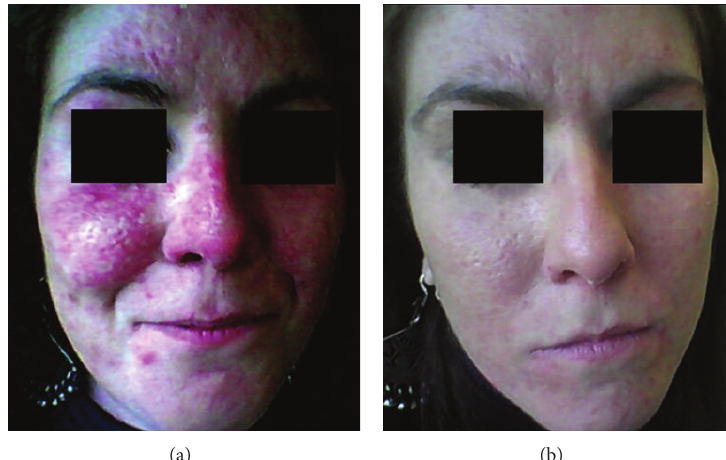
Figure 1: (a) SCLE: cutaneous eruption which infiltrates forehead, cheeks, and chin. (b) Disappearance of facial SCLE after the third cycle of TPE plus RTX.